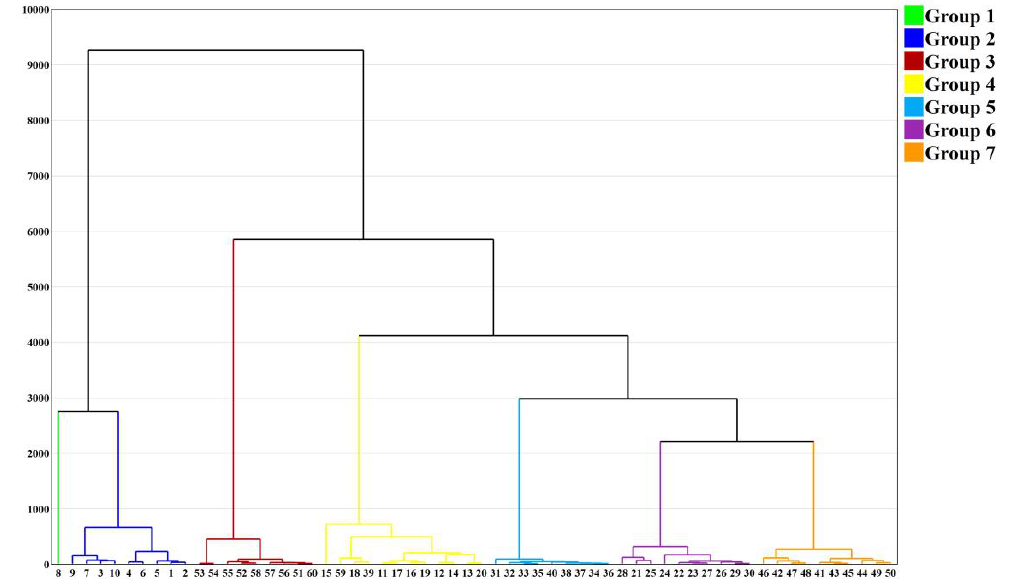
Figure 3. Hierarchical cluster dendrogram of the 60 data points of the six different grade phosphorite samples. Table 1. Hierarchy clustering groups of the 60 data points of the six different grade phosphorite samples.